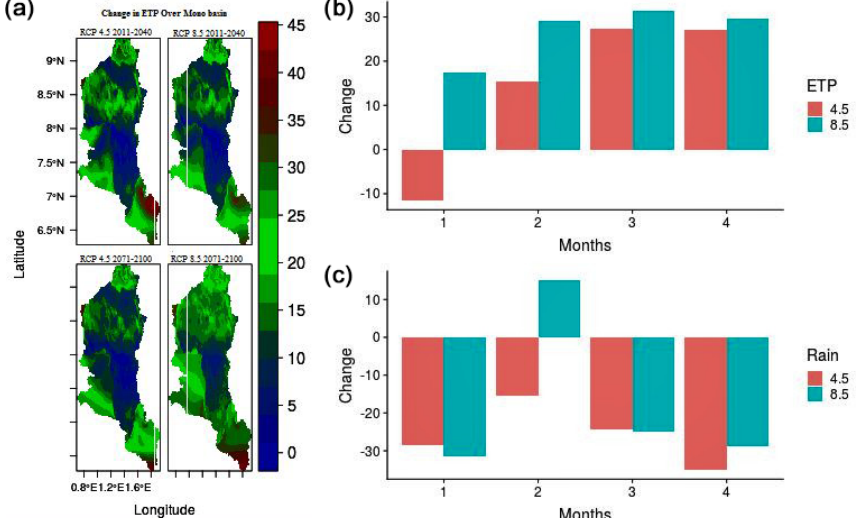
Figure 2. Spatial projected changes in ET (to the left, panel a ) projected changes average ET and rainfall for each calendar month from the reference period (1981–2010) to (2011–2100); (1: April, May, June; 2: July, August, September; 3: October, November, December; 4: January, February, March), (to the right, panels b and c ).